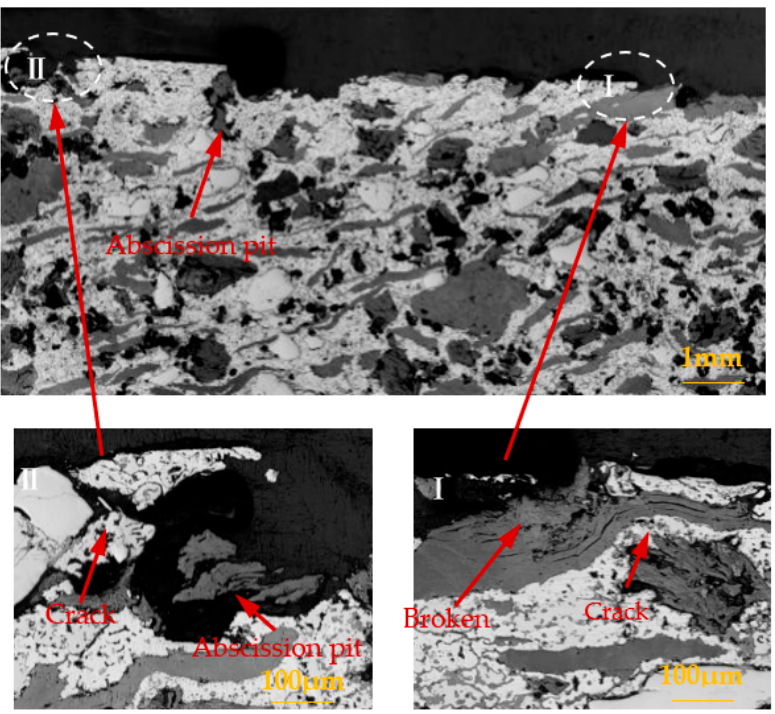
Figure 19. Profile photos of the brake pad material after intermittent brake wear at 0 °C.